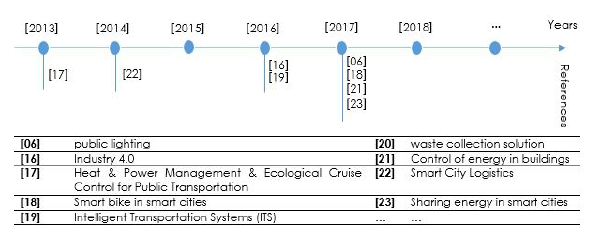
Figure 2. Some achievements encountered in the